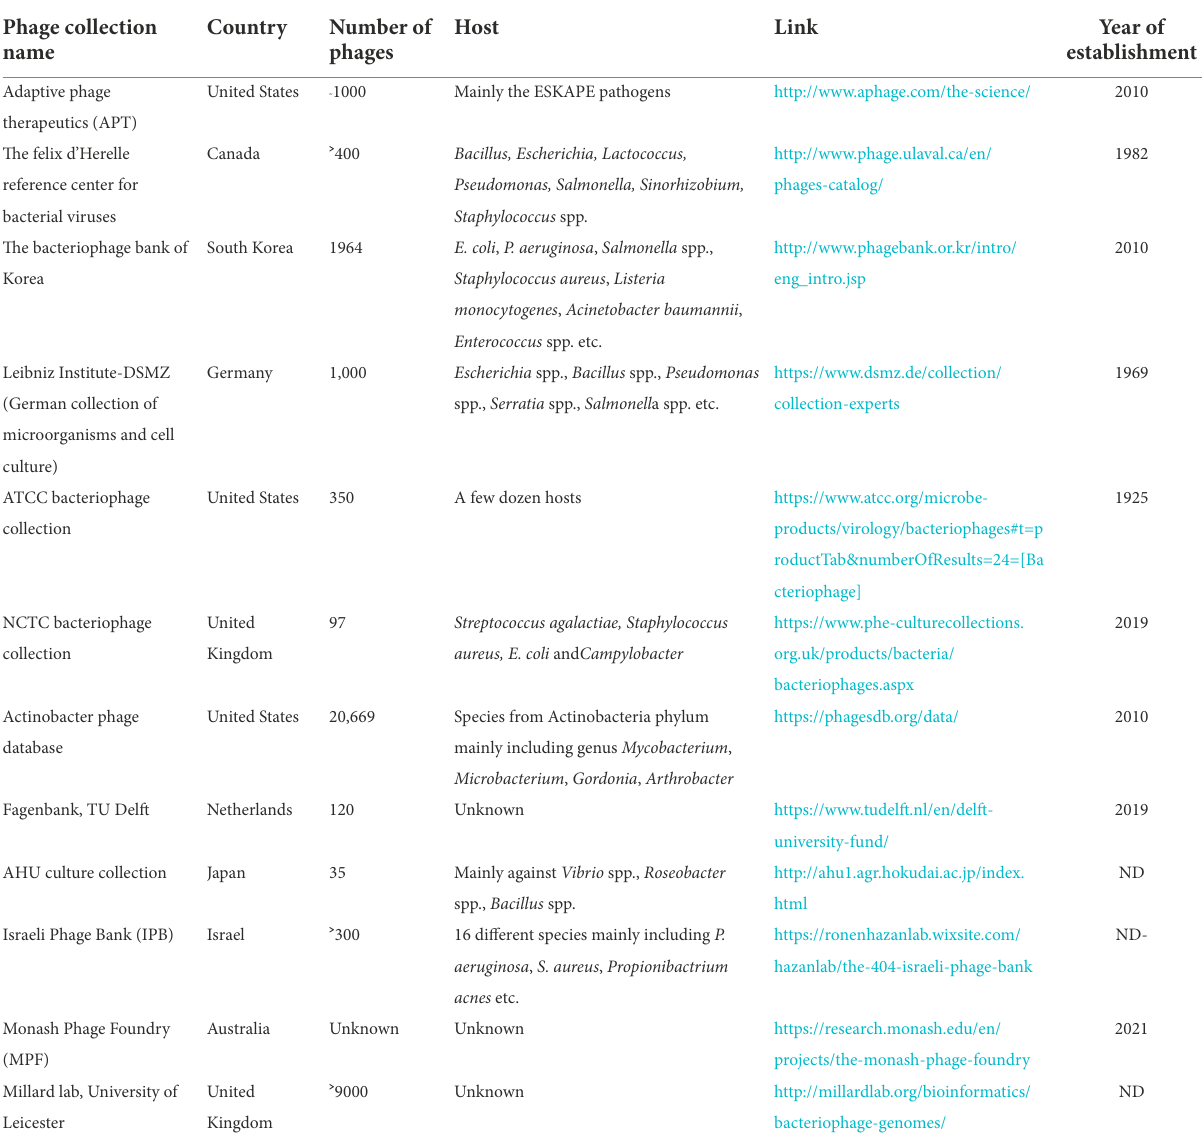
TABLE 1 Status of phage collections